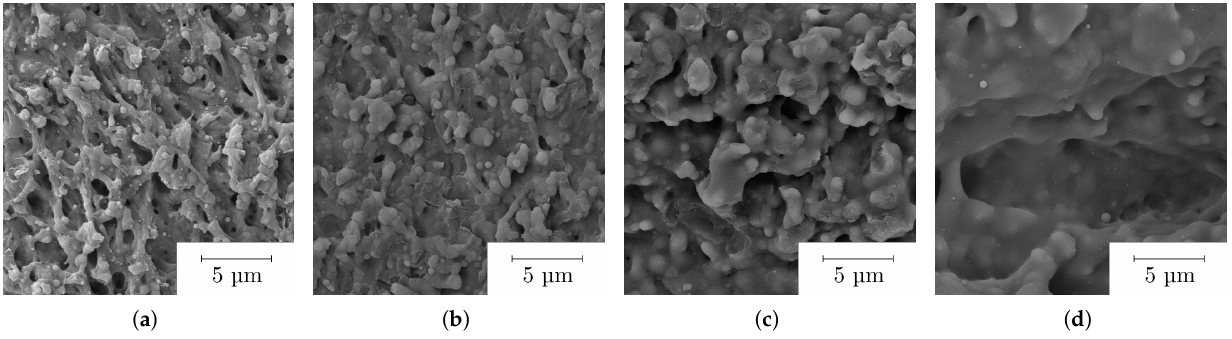
Figure 7. SEM image of the topography evolution of COC by the focused UV laser at the fluence of ( a ) 4.6 ( b ) 10.5 ( c ) 16.8 ( d ) 22Jcm − 2